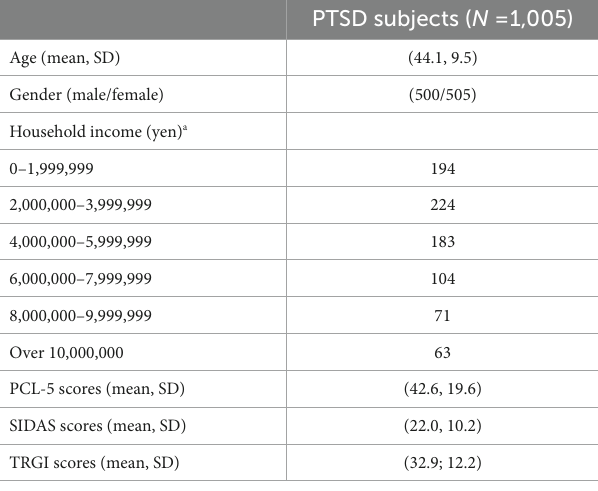
TABLE 1 Characteristics of included study participants.